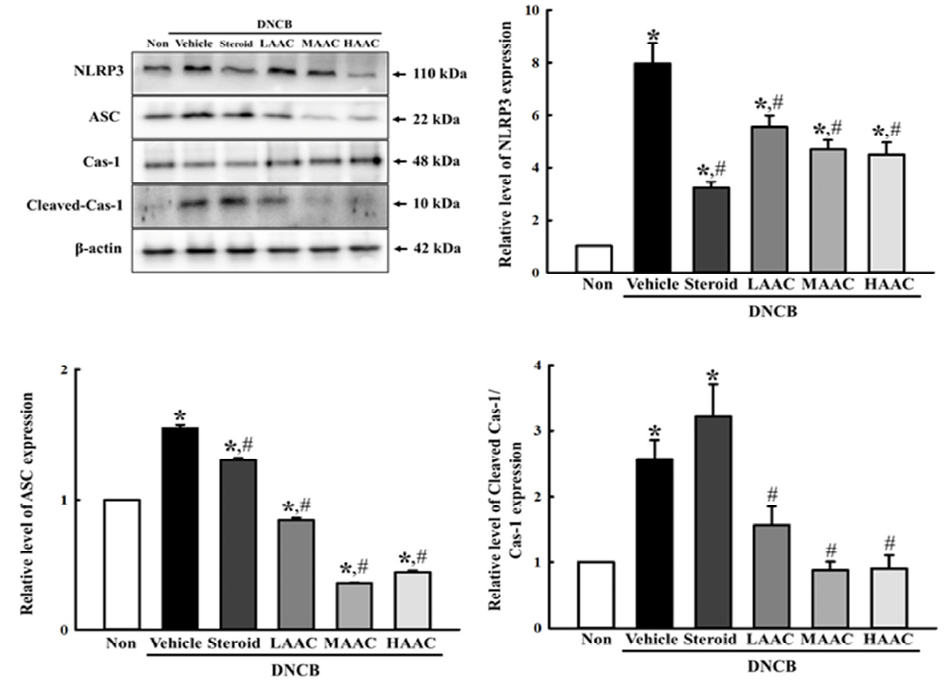
Figure 12. Inflammasomes levels in DNCB-treated BALB/c mice spread with AAC. After preparation of tissue homogenate from DNCB+AAC-treated BALB/c mice, the expression levels of the key regulators including NLRP3, ASC, Cas-1, Cleaved Cas-1, and β -actin were detected using Western blot analysis. The total proteins homogenates were prepared from five to six mice per group, and Western blot analyses for each sample were analyzed in duplicate. All values in the results are represented as the means ± standard deviation (SD). * indicates statically significance compared to the non-treated group, while # indicates statistical significance compared to the DNCB+Vehicle-treated group. Abbreviations: AA, abietic acid; DNCB, 2,4-dinitrochlorobenzene; LAAC, low concentration of AA cream; MAAC, medium concentration of AA cream; HAAC, high concentration of AA cream.